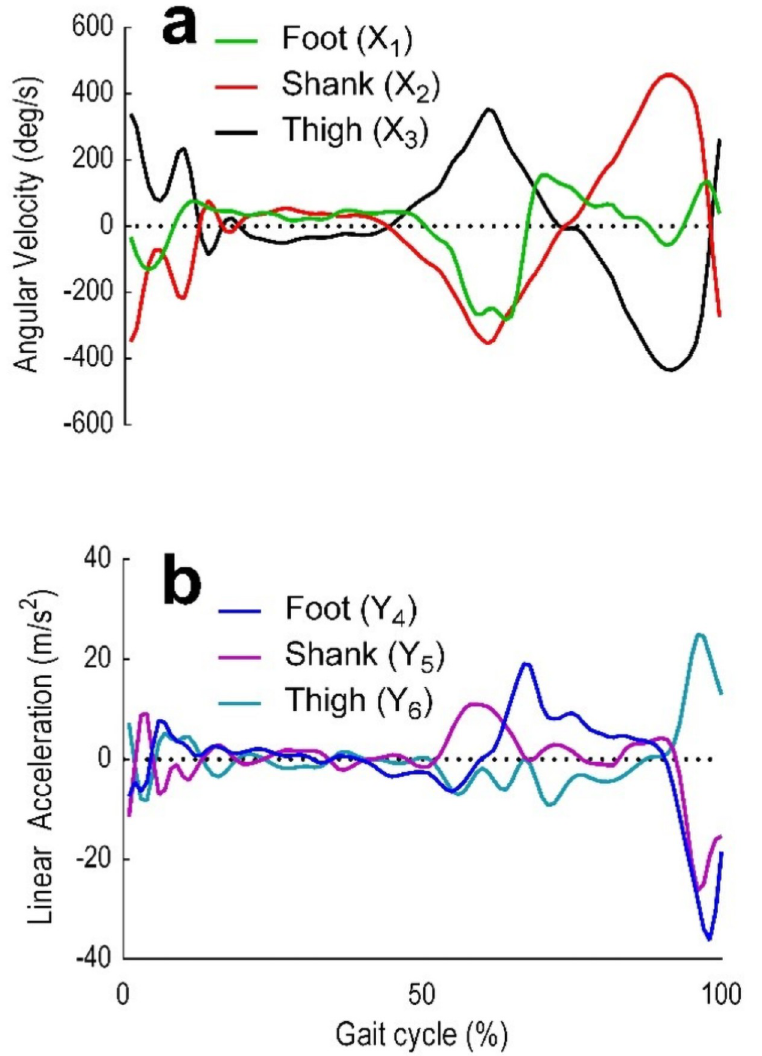
Fig 2. Foot, shank and thigh sagittal plane AV and LA. Those were selected as the model’s independent variables predominantly because primary motions of the human movement are flexion and extension in the sagittal plane (6). (a) Foot (X 1 ), shank (X 2 ) and thigh (X 3 ) AV. (b) Foot (Y 1 ), shank (Y 2 ) and thigh (Y 3 ) LA.